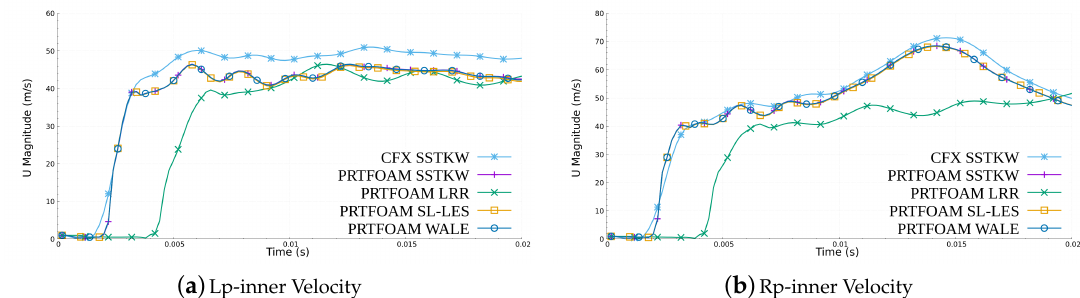
Figure 19. Velocity–time curves of the simulation results of different models at the ( a ) Lp-inner and ( b ) Rp-inner sampling points. The curves of PRTFOAM SSTKW, PRTFOAM SL-LES, and PRTFOAM WALE basically coincide. The velocity of the sampling point on the left side is stable at approximately 45 m/s, while that of the sampling point on the right side is stable at approximately 50 m/s.